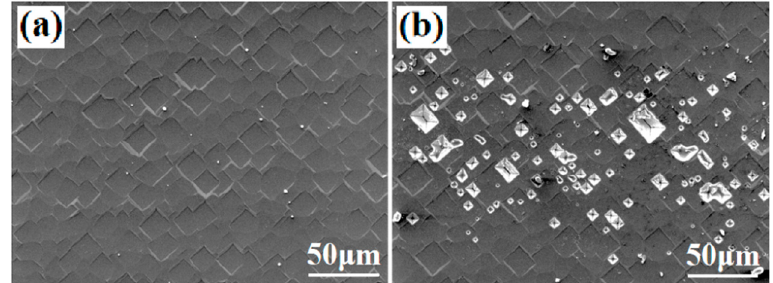
Figure 3. The surface morphologies two cells after the contact pastes were etched away. ( a ) Cell with conventional PERC Al paste; ( b ) cell with firing-through Al paste.